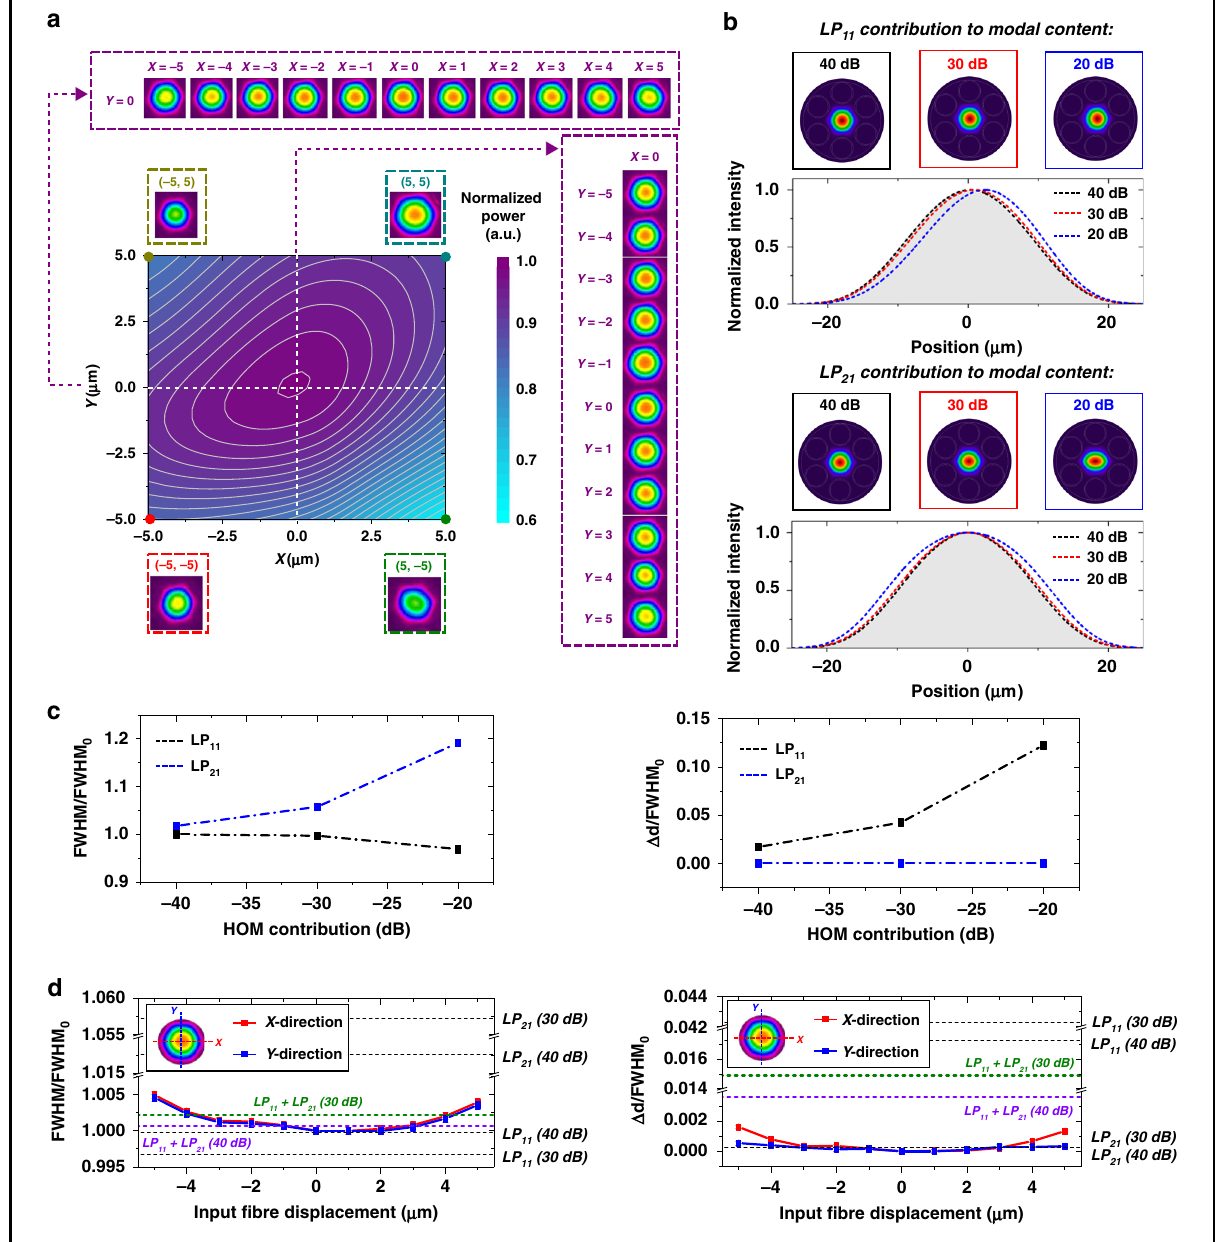
Fig. 7 Single modedness robustness. a Normalised power and near- fi eld pro fi les at the fi bre output for different input conditions at 1064 nm. b Intensity mode pro fi les considering a fi bre modal content dominated by the fundamental mode and with different HOM levels added to the modal content. c Simulated normalised beam full width at half maximum (FWHM/FHWM 0 ) and centroid variation ( Δ d /FHWM 0 ) for different HOM contributions to the fi bre modal content. d Measured FWHM/FHWM 0 and Δ d /FHWM 0 of the output beam as the input fi bre position was scanned along the horizontal direction, i.e., Y = 0 in a . Horizontal lines represent the simulated FWHM/FHWM 0 and Δ d /FHWM 0 values. In the superposition cases, we assume equally weighted combinations of the LP 11 and LP 21 modes contributing to the modal content at extents of 30 and 40